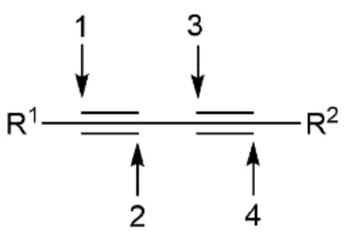
Figure 1. The four reactive positions of conjugated